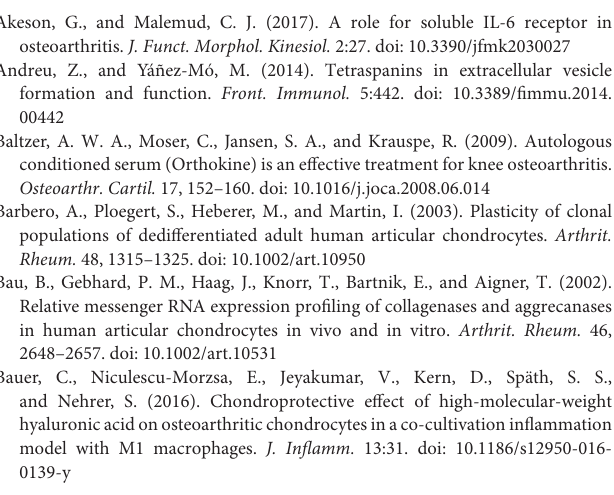
Supplementary Figure 1 | Extracellular vesicle (EV) gating strategy and control experiments for flow cytometric characterisation of EVs in native blood products.